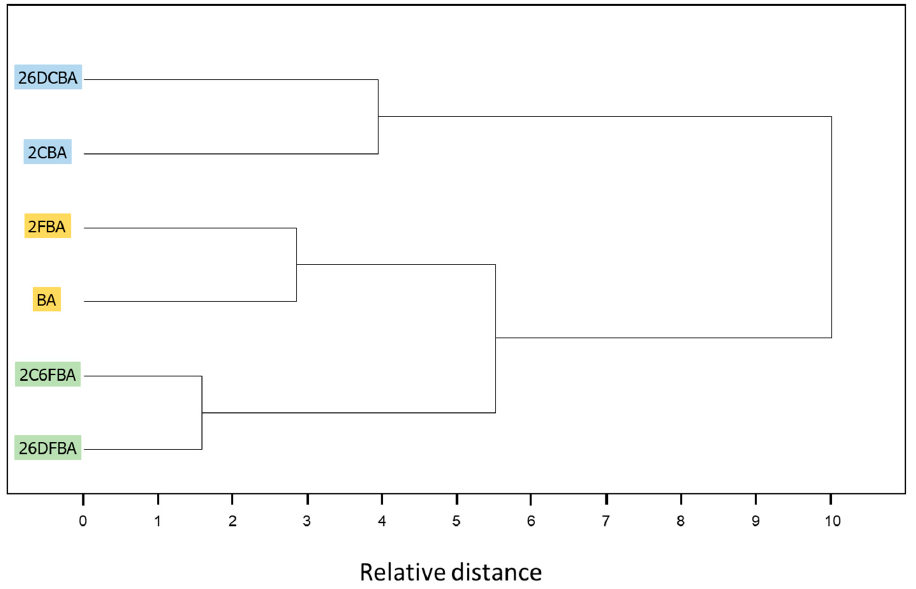
Figure 24. Results of clustering analysis (Ward’s method with squared Euclidian distance) of the CE-B3LYP data for the crystals of the studied compounds. For this analysis, the UnscramblerTM CAMO software (Version 10.5) [76] was used.